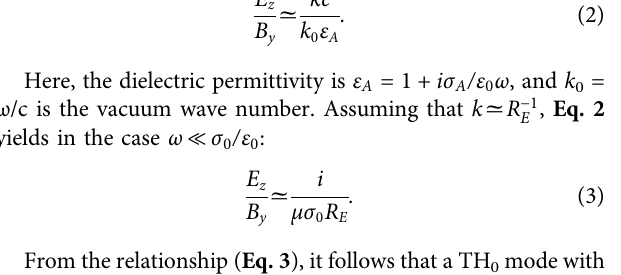
Frontiers in Earth Science |